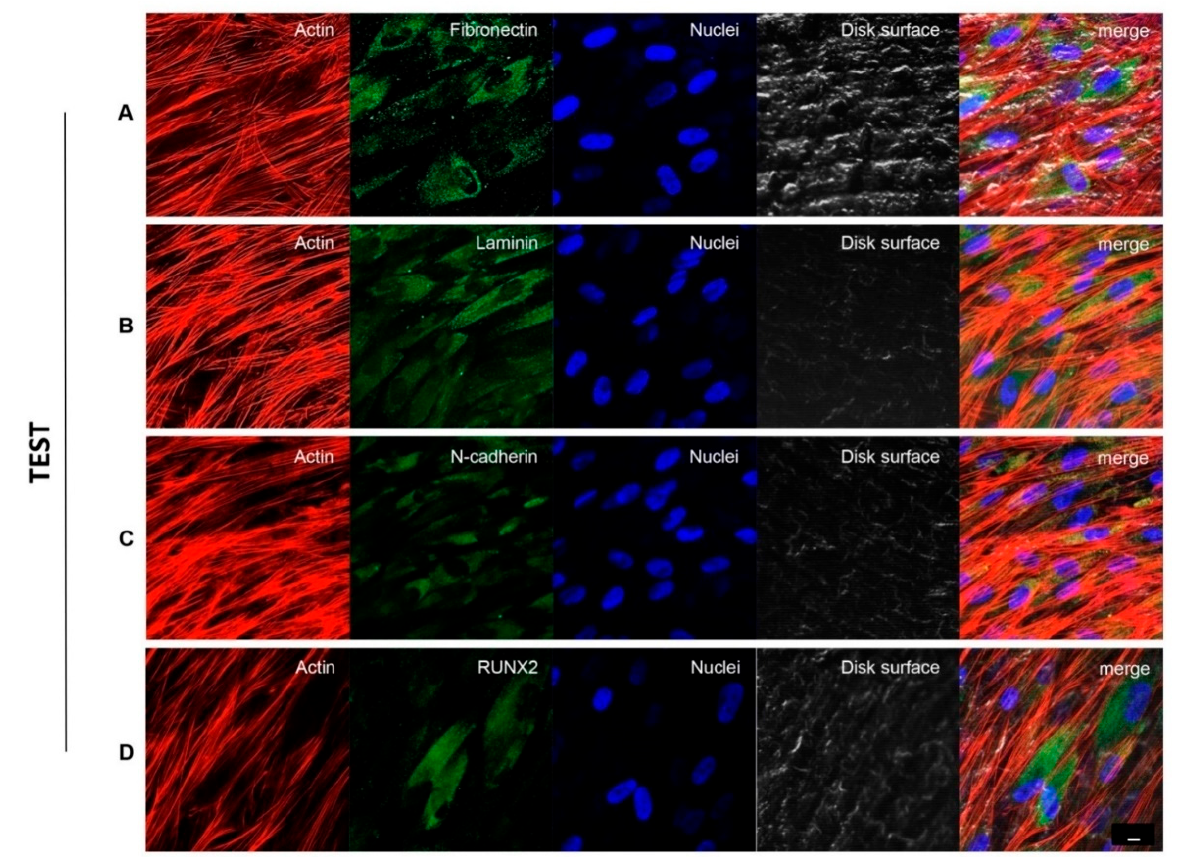
Figure 4. hPDLSCs cultured on TEST titanium implant surface observed after 8 weeks. Cytoskeleton actin was stained in red fluorescence; specific markers: Fibronectin ( A ), Laminin ( B ), N-cadherin ( C ) and RUNX2 ( D ) were stained in green fluorescence; nuclei were stained in blue fluorescence. Scale bar: 10 μ m.